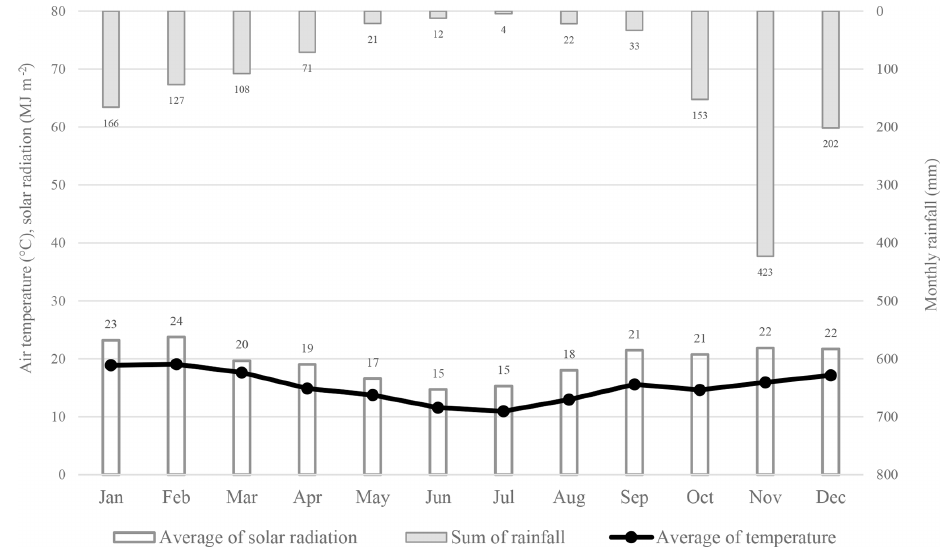
Figure 3. The monthly rainfall, monthly solar radiant density and average monthly air temperatures at New Forest averaged over 2 years.